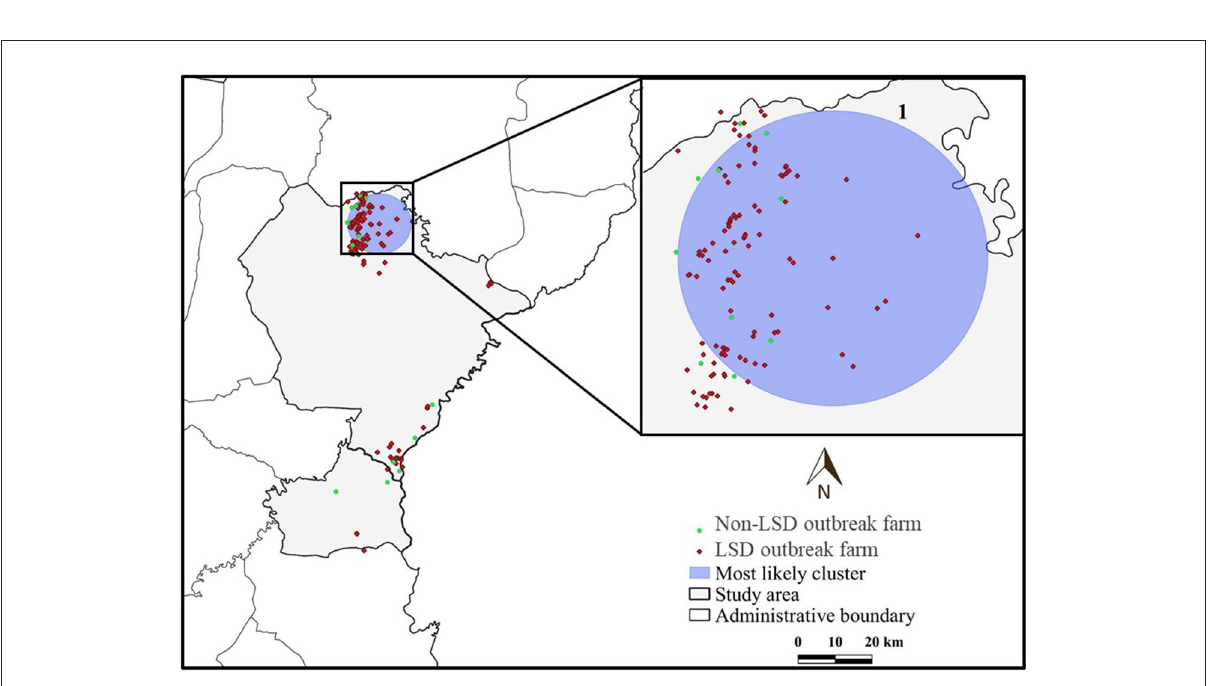
FIGURE5 Spatio-temporal clusters of lumpy skin disease (LSD) outbreaks in dairy farms, Khon Kean province, Thailand detected by the Bernoulli model.